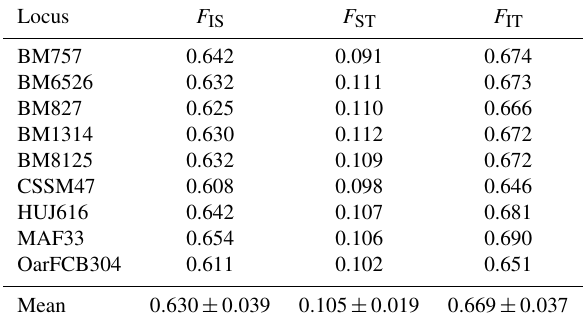
Table 4. Wright’s F -statistics parameters for studied loci. Locus